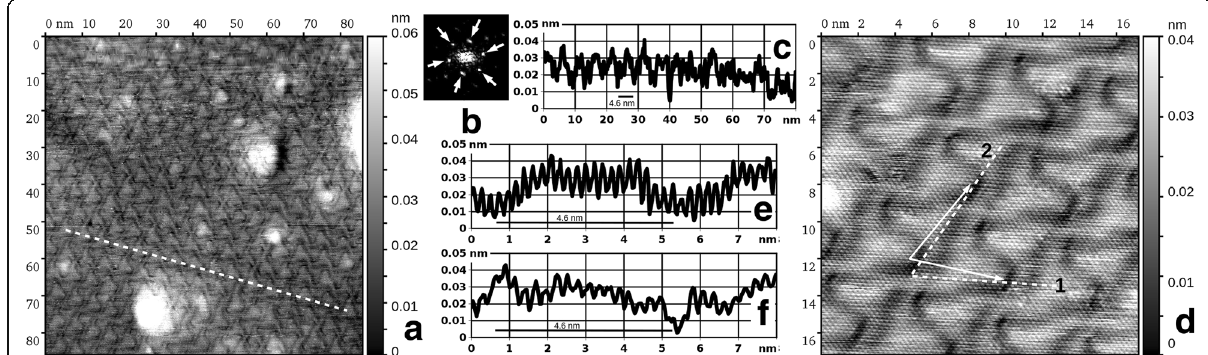
Fig. 3 STM images of the 9 ML Au film grown on Ru(0001) at RT and annealed at 1050 K during 5 min: a field of view 86 nm × 86 nm, sample bias voltage: U = − 0.003 V, tunneling current: I = 10 nA. b FFT transform of the image ( a ) shown is a square section of the reciprocal space with a side of 1 nm − 1 , the 0th order spot is exactly in the middle. c Cross-section along the white dashed line in a . d Field of view 17 nm × 17 nm, sample bias voltage − 0.003 V, tunneling current 50 nA; white arrows designate the primitive translation vectors of the surface superstructure. e, f Cross-sections along the dashed lines 1 and 2 in d . An individual gray scale (height-to-color correspondence) is given to the right of images a and d . 4.6 nm bars are given as black solid lines on the graphs in c , e ,